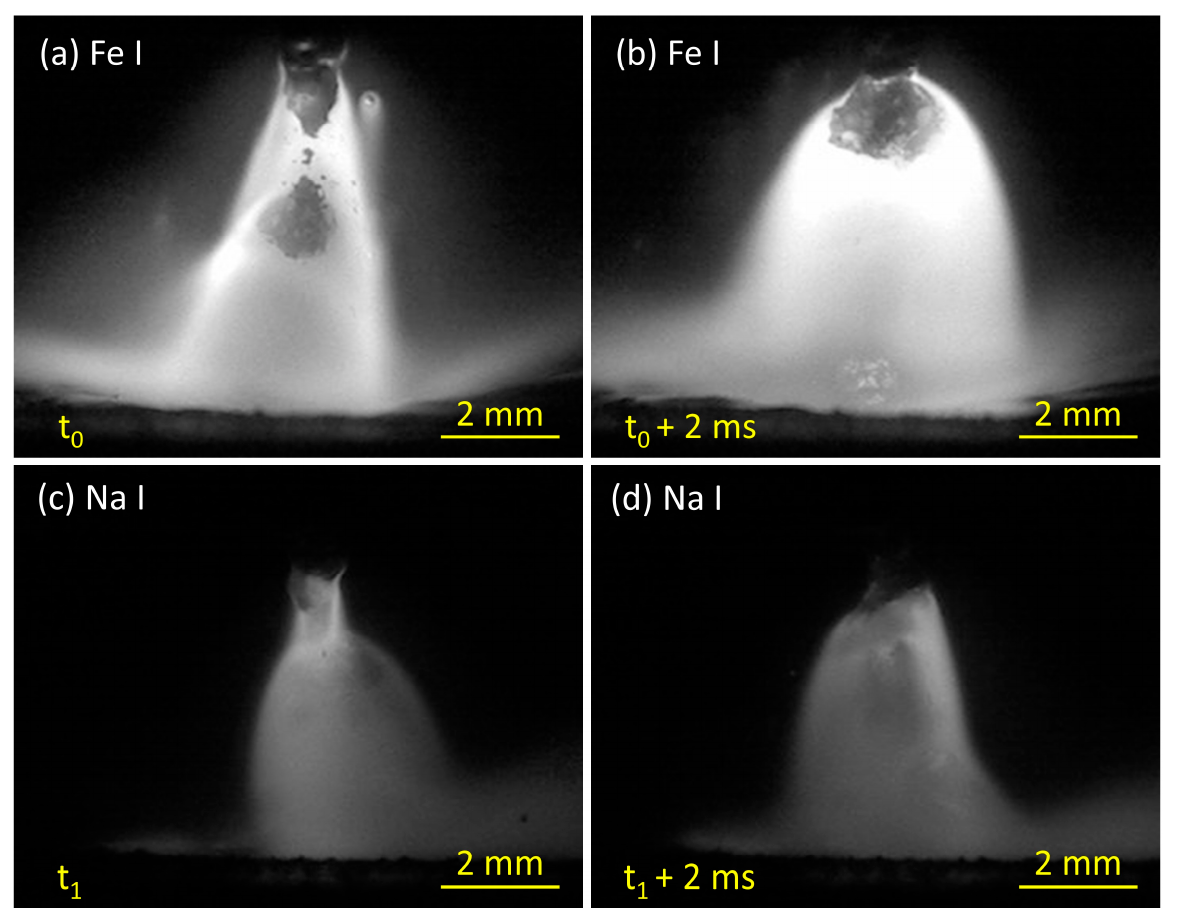
Figure 6. The typical images of iron vapor plasma ( a , b ) and sodium vapor plasma distribution ( c , d ) of wire 3 at 320 A of welding current.